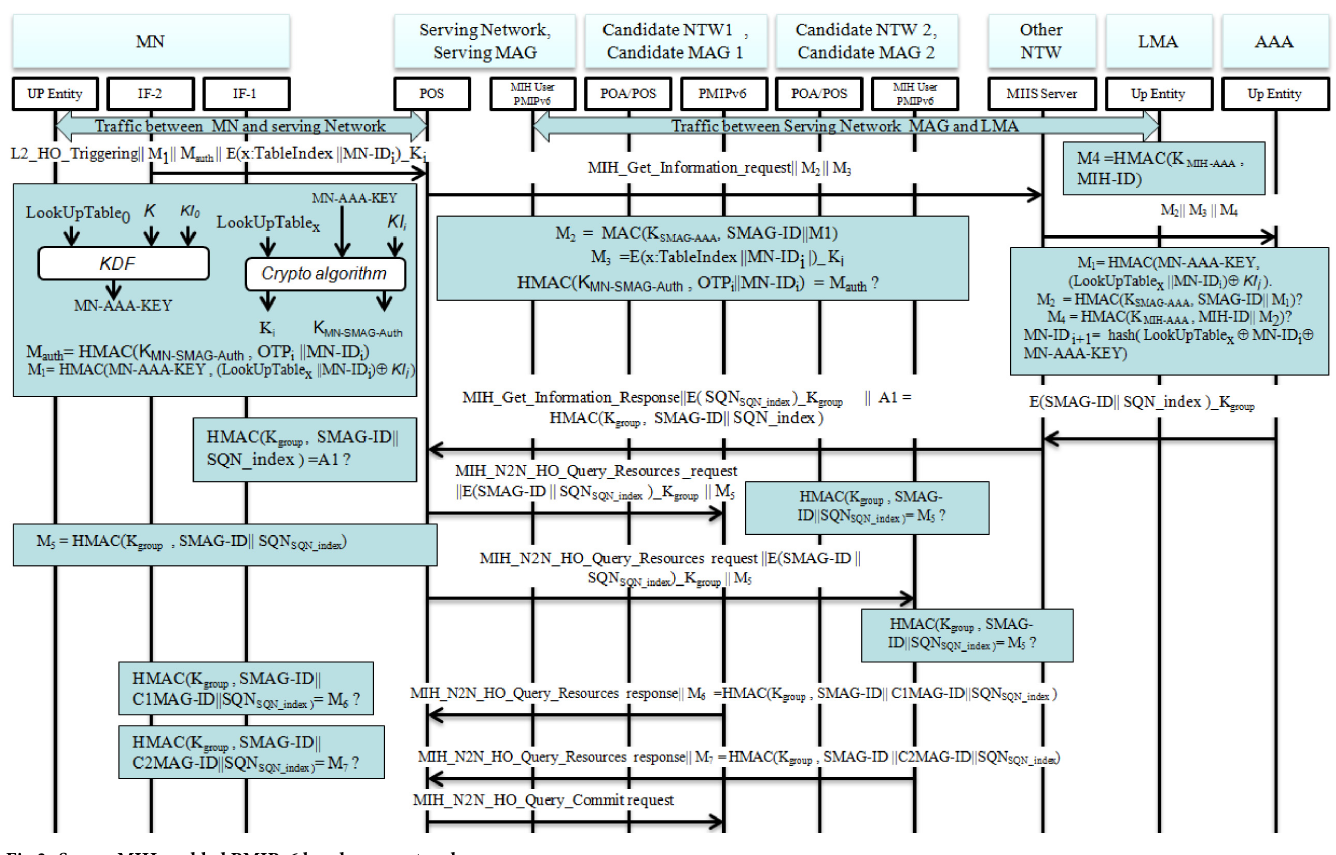
Fig 3. Secure MIH enabled PMIPv6 handover